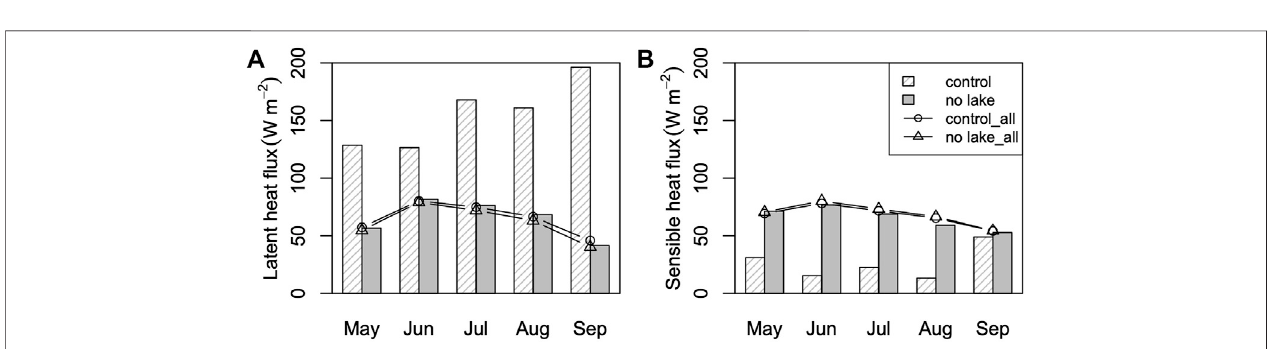
FIGURE 3 | The comparison of monthly mean latent heat fl ux (A) and sensible heat fl ux (B) simulated by the experiments with and without lakes. The histogram shows the average sensible heat/latent heat fl ux in the lake area, and the solid line shows the average sensible heat and latent heat changes over the entire study area.